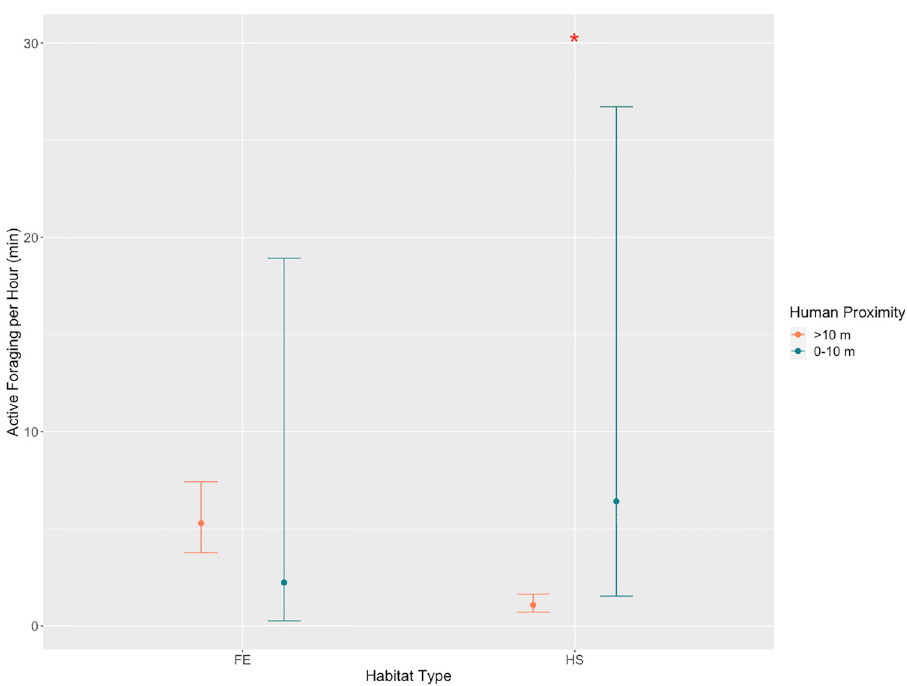
Fig 4. Predicted mean active foraging per hour across human proximity distance classes in two modified habitats types, with 95% confidence intervals. � Statistically significant at p � 0.05. FE = Forest Edge, FI = Forest Interior, OFP = Open Forest Patch, HS = Human Settlement.